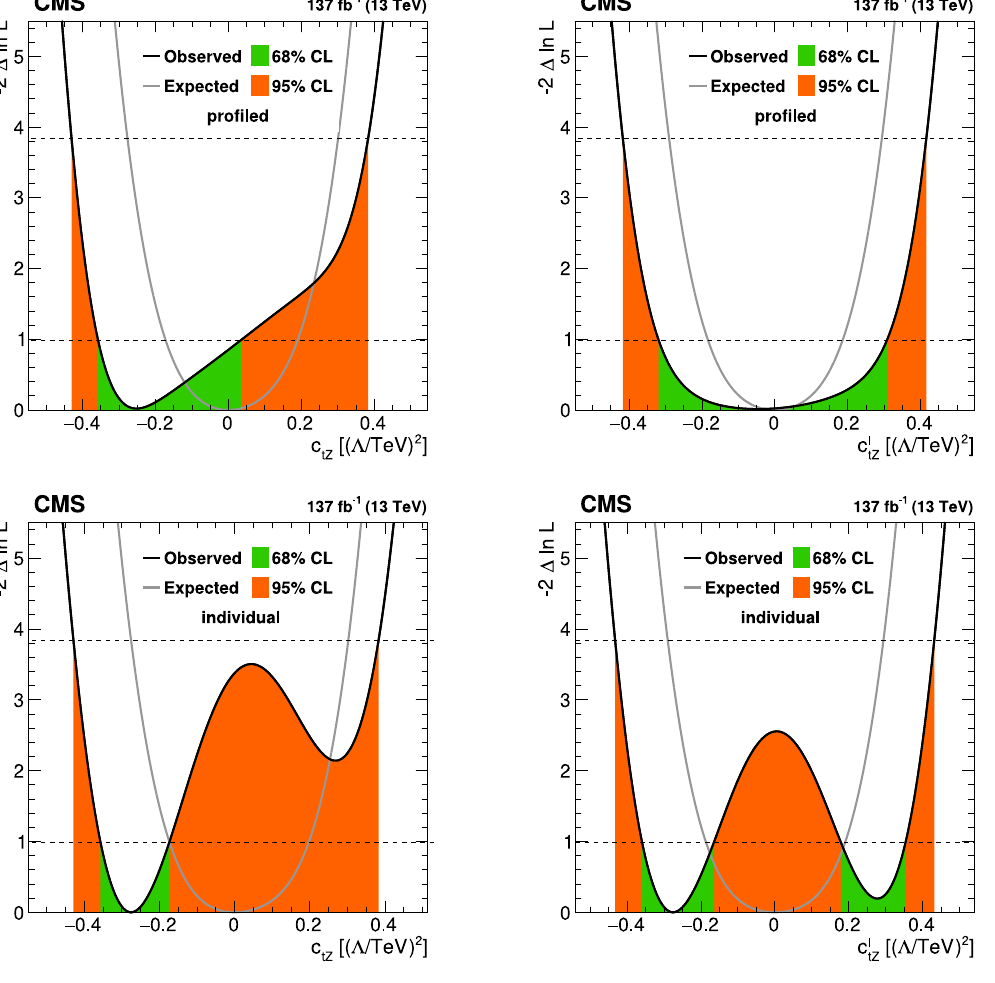
(left) and c I (right). tZ tZ